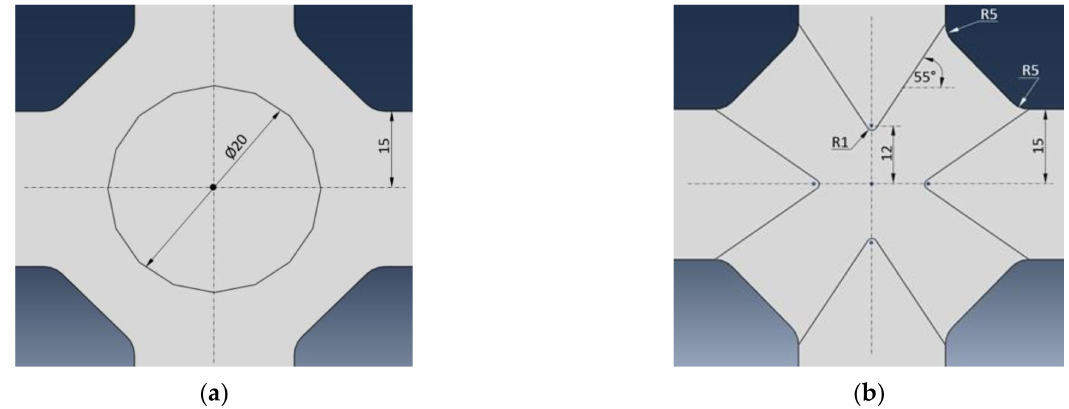
Figure 5. Two geometries of the non-treated gauge area: ( a ) Specimen_1, ( b ) Specimen_2. Sheet metal samples were cut into cruciform geometry using a waterjet. Samples were subjected to the nitriding procedure under the same process conditions (520 ◦ C, 180 min) as the dog-bone shaped specimens used for the tensile tests described above. In order blocking paste, on both sides. Figure 6a,b presents the final shapes of the samples that were nitrided: the area of the specimen that was nitrided is marked with the red colour, whereas the blue colour represents the raw material.